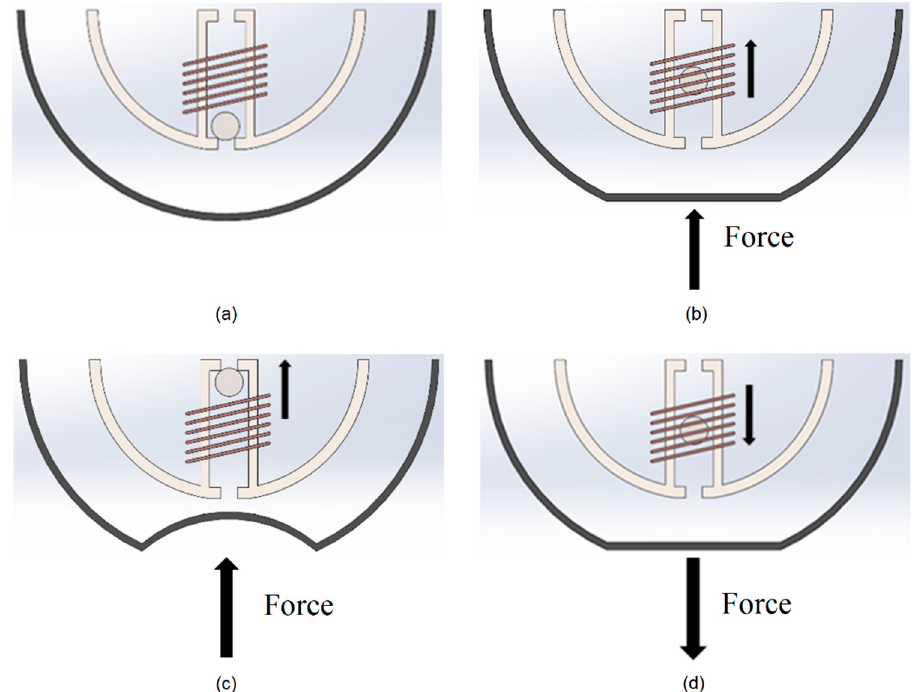
Figure 2. Working Principle of the energy harvester. The ball magnet initially falls in the bottom of the tube due to gravity ( a ). When the outer surface of the harvester shell is pressed, the reservoir is compressed displacing the fluid through the tube, pushing the ball magnet through the coil and inducing a voltage in the coil ( b , c ). When the force is taken away from the bottom side of the shell, the fluid and ball return to their original state downwards through the coil, inducing a negative voltage in the coil ( d ).